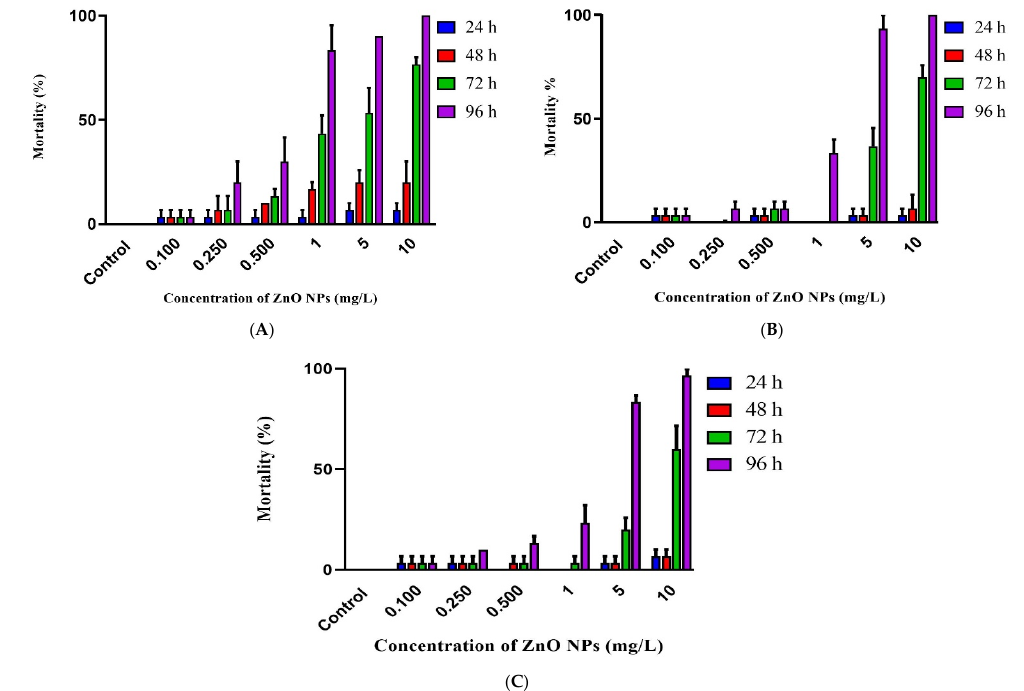
Figure 3. Mortality of Javanese medaka embryos at various time intervals following exposure to different concentrations of ZnO NPs in ultra-pure water ( A ), deionized water ( B ), and dechlorinated tap water ( C ). The lowest 96 h LC 50 value determined by probit analysis for ZnO NPs on Javanese medaka embryos was in ultra-pure water (0.6438 mg/L) followed by deionized water